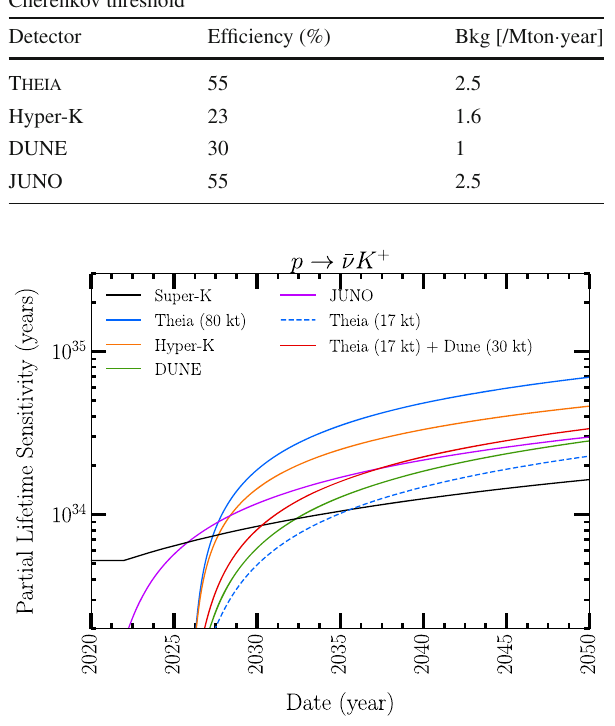
Fig. 20 Sensitivity for p → ¯ ν K + is highest for Theia , closely fol- lowedbytheHyper-Kdetector,whereasJUNOandDUNEwillperform similarly